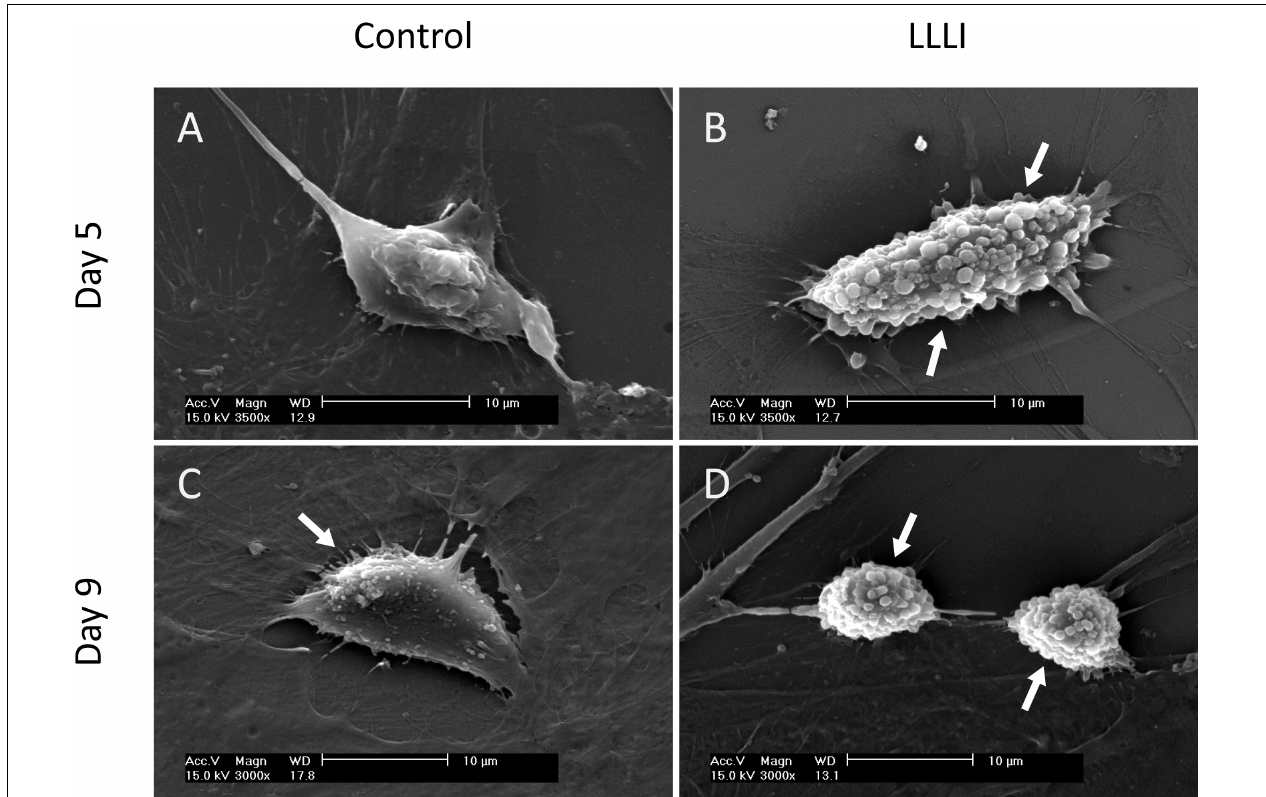
FIGURE 2 | Sub-cellular analysis of rabbit chondrocytes by SEM. (A) Chondrocytes cultured in monolayer for 5 days only (control); (B) Chondrocytes cultured in monolayer treated with LLLI of 5.74 J/cm 2 daily in culture for 5 days; (C) Chondrocytes cultured in monolayer for 9 days only (control); (D) Chondrocytes were treated with LLLI of 5.74 J/cm 2 daily in culture for 6 days followed by further culture up to day 9. “Arrows” indicates secretory granules on the cell surface. Scale bar (—) represents 10 µ